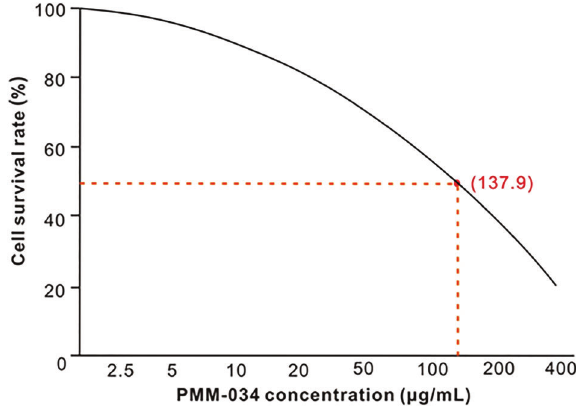
Figure 2. Cytotoxicity of shikonin ester derivative PMM-034 on rhabdomyosarcoma cell viability. PMM-034 was serially diluted to 0, 2.5, 5, 10, 20, 50, 100, 200, and 400 m g/mL in DMEM containing 2.5% FBS. Subsequently, the cytotoxicity of PMM-034 on RD cells was determined by the WST-1 assay. Data are reported as means ± standard deviation (SD) from at least three independent experiments. The red dot indicates the PMM-034 concentration under 50% cell survival